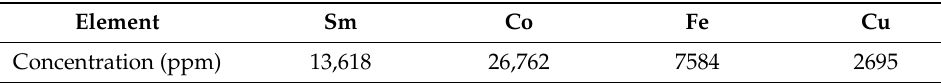
Table 2. Metal composition of